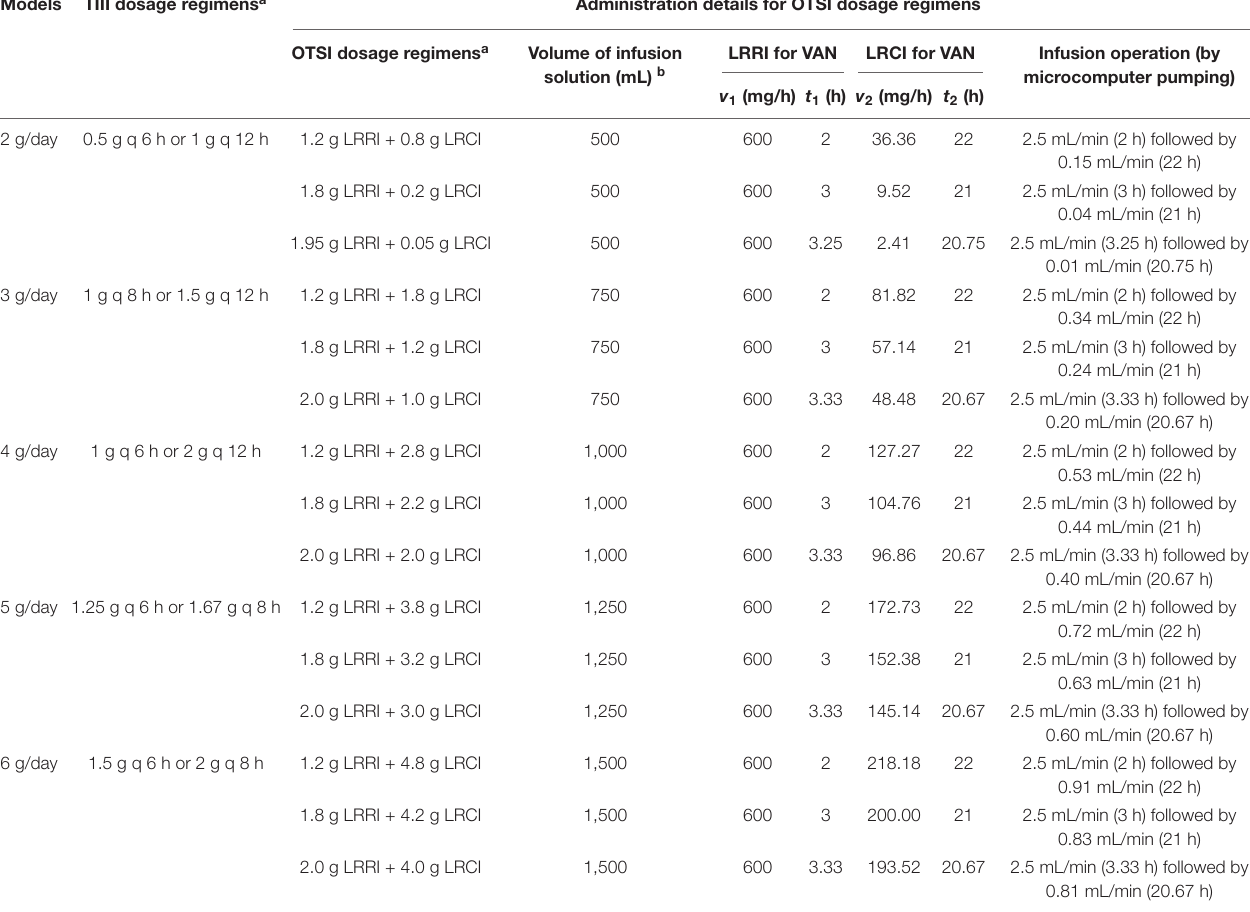
TABLE 1 | Simulated dosage regimens and administration details. Models TIII dosage regimens